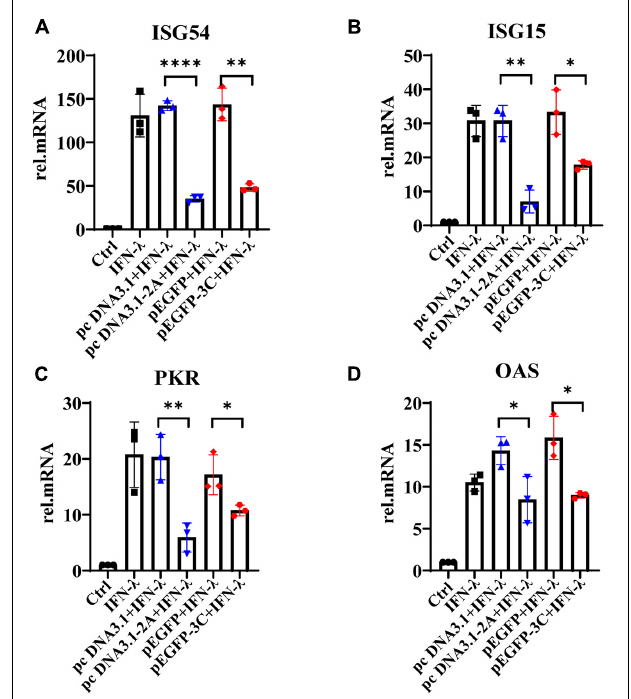
FIGURE 6 | The 2Apro and 3Cpro of EV71 inhibit the production of antiviral proteins downstream of the IFN- λ pathway. HT29 cells were transfected with pcDNA3.1-2A (pcDNA3.1) or p-EGFP-3C (p-EGFP). After transfection 24 h, cells were stimulated by IFN- λ (10 ng/ml). The cells were collected 24 h later, and the mRNA expression levels of (A) ISG54, (B) ISG15, (C) PKR, and (D) OAS were measured by qRT-PCR. Control was cells without any treatment. Dates were presented as mean ± SD ( n = 3 independent experiments, ∗ P < 0.05, ∗∗ P < 0.01 and ∗∗∗∗ P <